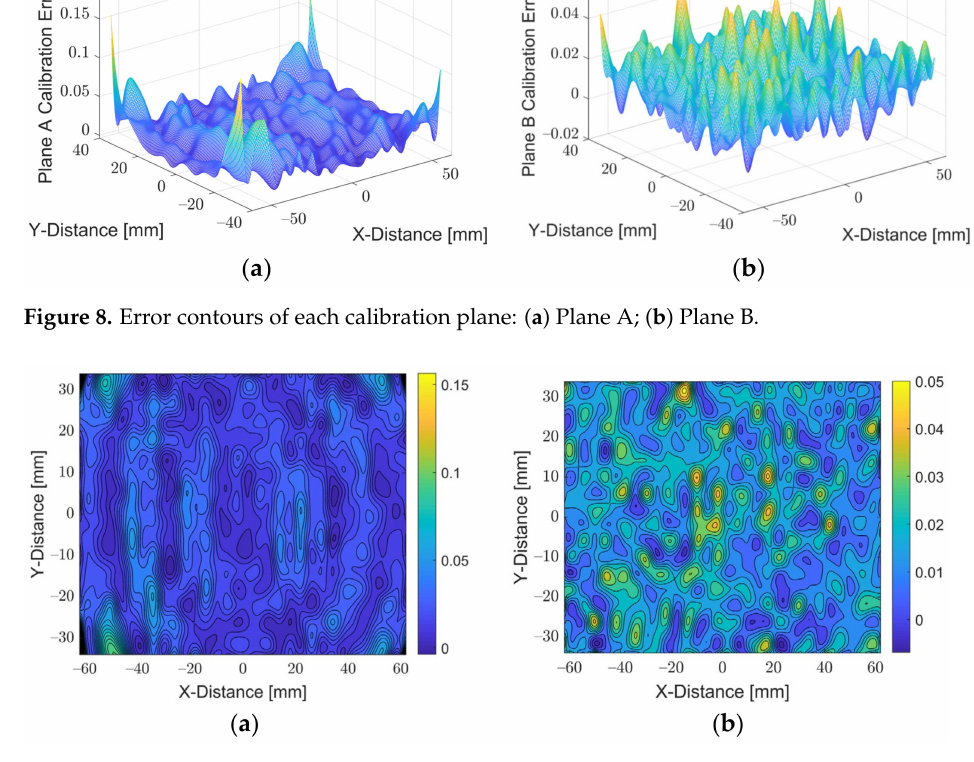
Figure 9. Error contours of each calibration plane: ( a ) Plane A; ( b ) Plane